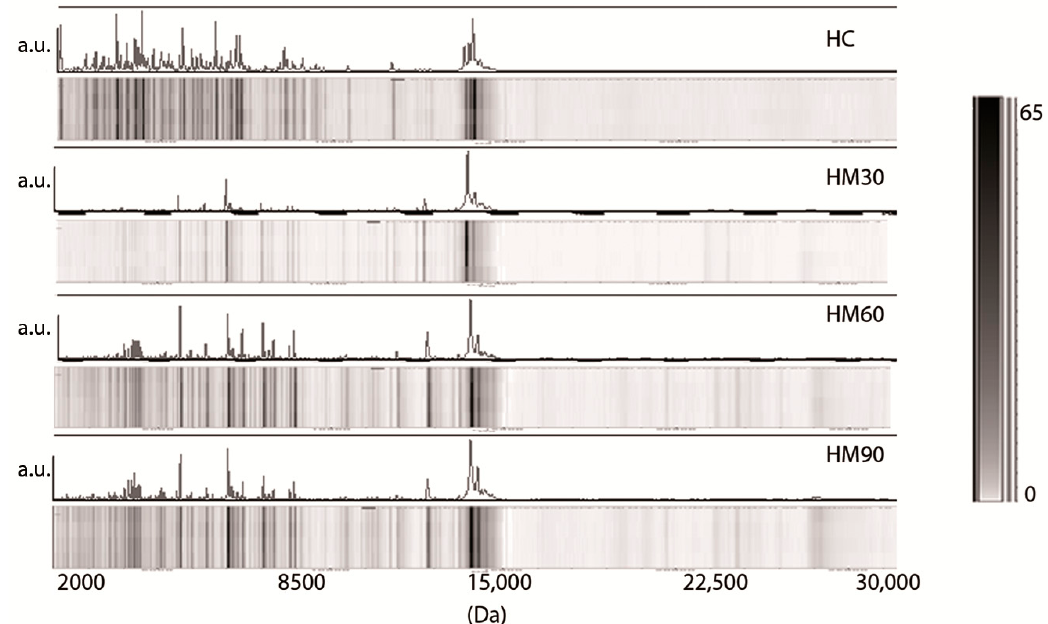
Figure 1. Representative matrix-assisted laser desorption/ionization-time-of-flight mass spectrometry (MALDI-TOF MS) profiling and pseudogel view of crude human milk at two, 30, 60, and 90 days of lactation, indicated respectively as HC, HM30, HM60, and HM90. The mass-to-change ratios ( m / z ) are reported on the X axis (Da), while the peak intensities are indicated as arbitrary units (a.u.) in the gray scale bar on the Y axis.